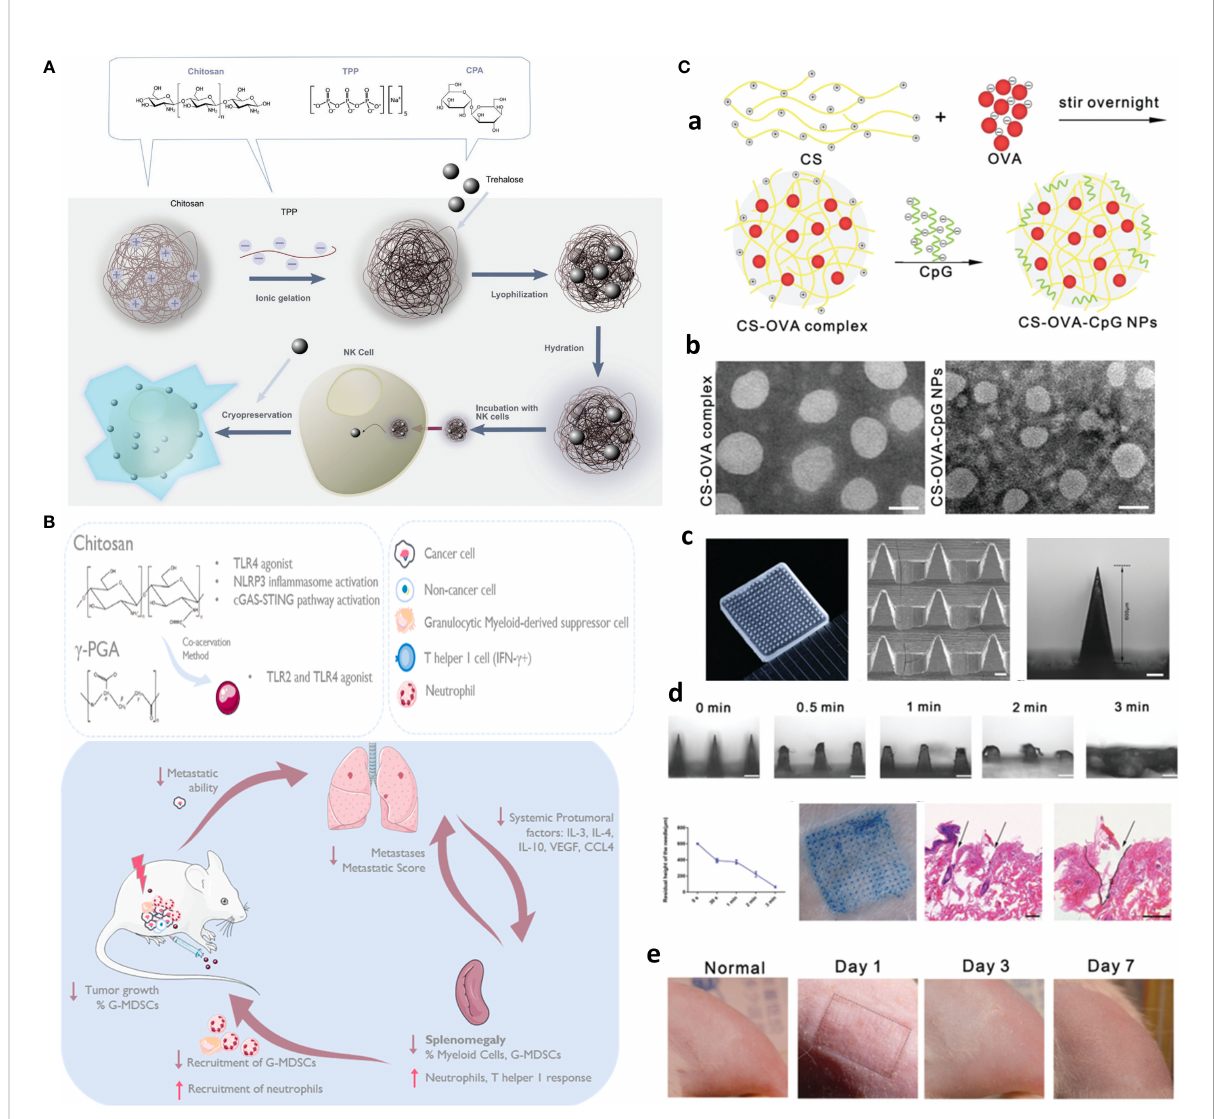
FIGURE 8 Chitosan-based platforms for active immunotherapy and metastasis inhibition. (A) Chitosan NPs for NK cell preservation and delivery. Reprinted from (119) under Creative Commons Attribution License 4.0, Copyright (2020) WILEY ‐ VCH Verlag GmbH & Co. KGaA, Weinheim. (B) Integration of chitosan Ch/ g -PGA NPs with radiotherapy boost immune response and elicit antimetastatic potential. Reprinted with permission from (120), Copyright (2020) Elsevier. (C) Chitosan NP-loaded MN patch for systemic vaccination in mice. (a) Schematics of synthesis of CS – OVA – CpG NPs; (b) TEM; (c) macroscopic and SEM images; (d) dissolution kinetics, insertion, and biocompatibility in BALB/c mouse skins; and (e) rat skin. Reproduced with permission from (121), Copyright (2020) Royal Society of